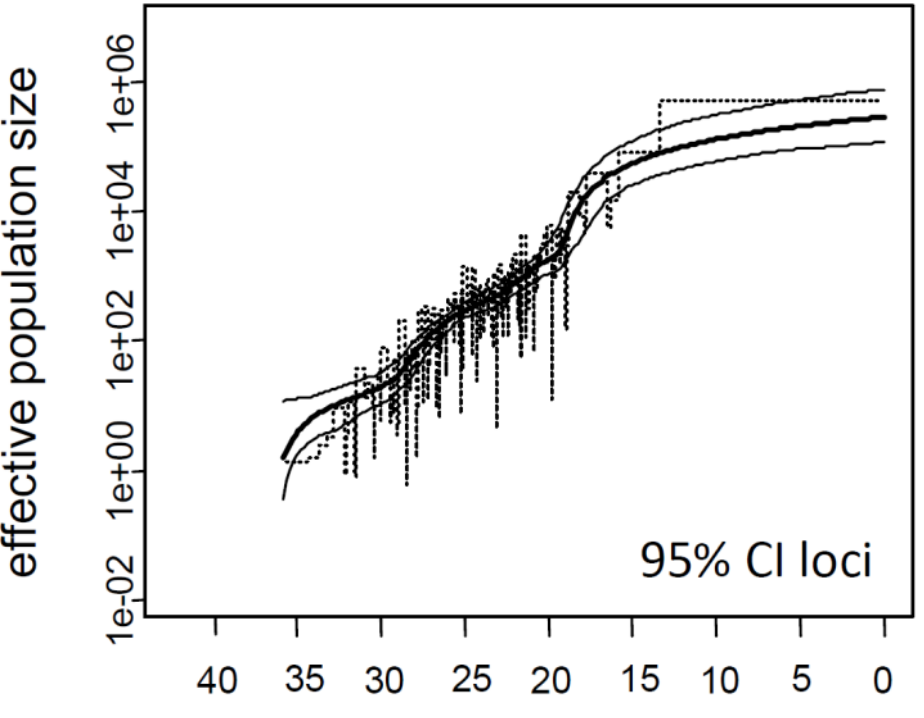
Figure 2. Demographic skylines of total populations of K. obovata in Southeastern China estimated by loci of 95% CI. Dotted lines are the classic skylines; thin and bold lines are the medians and 95% CI of skylines are estimated by rjMCMC